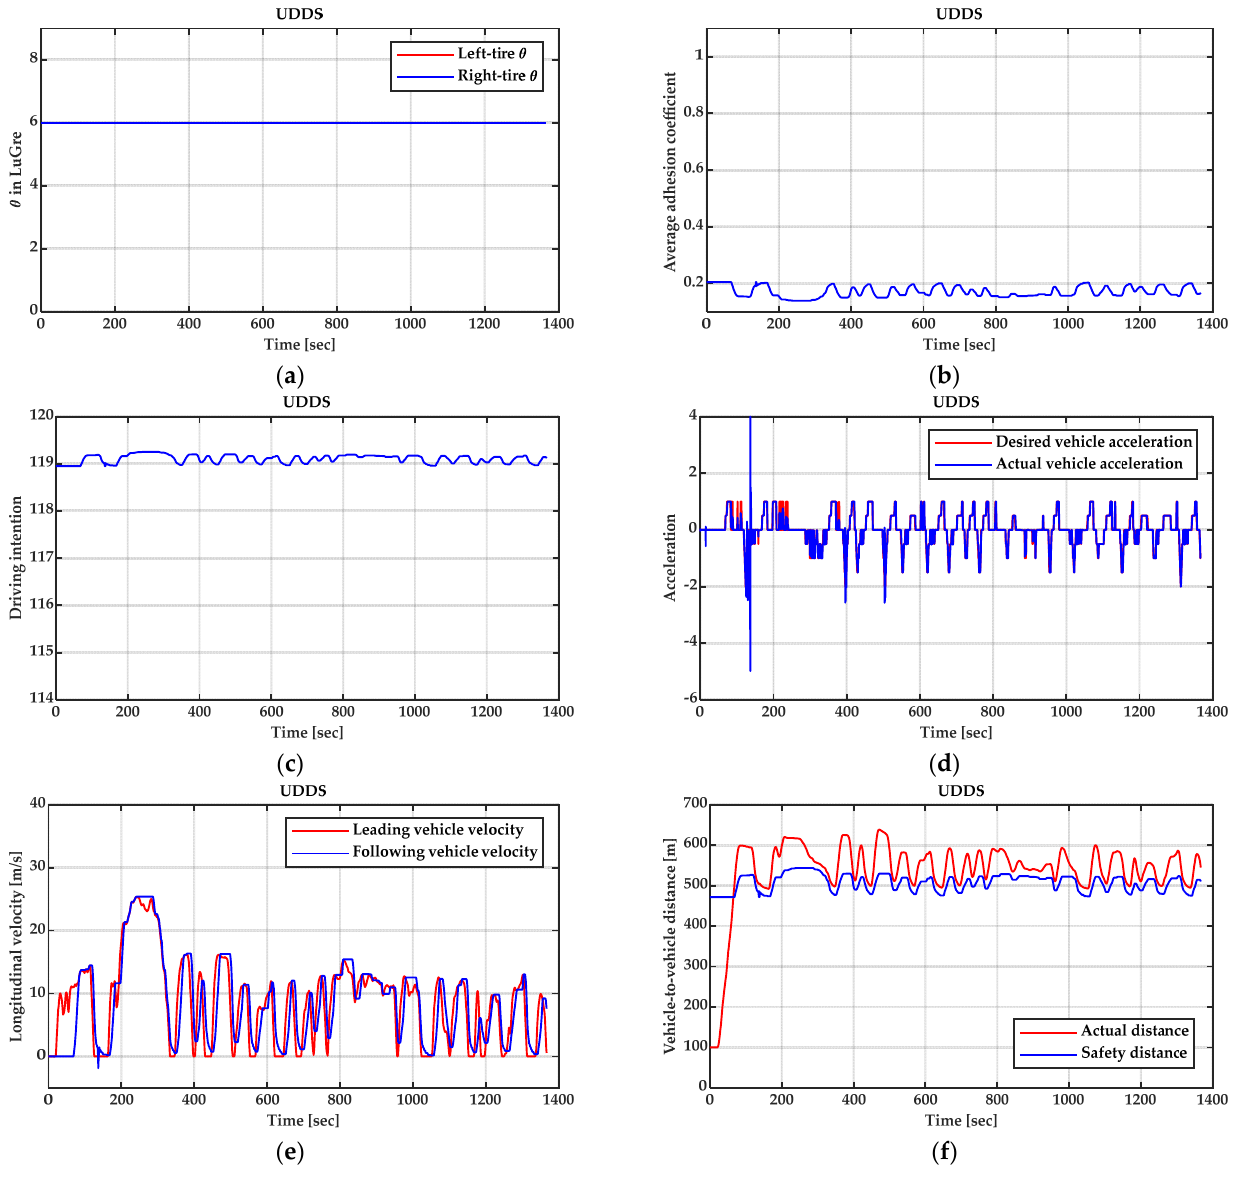
Figure 6. Snow and ice road experiments in UDDS with deep neural network. ( a ) Road characteristic parameter of left and right tires. ( b ) Average adhesion coefficient. ( c ) Driving intention. ( d ) Acceleration of following vehicle. ( e ) Longitudinal velocities of leading and following vehicles. ( f ) Vehicle-to-vehicle distance and actual distance.